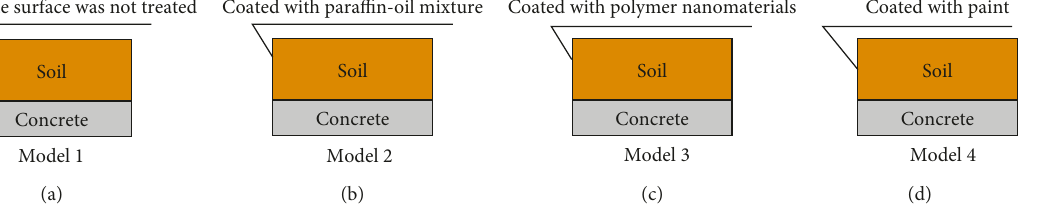
Figure 4: Four concrete surface treatments